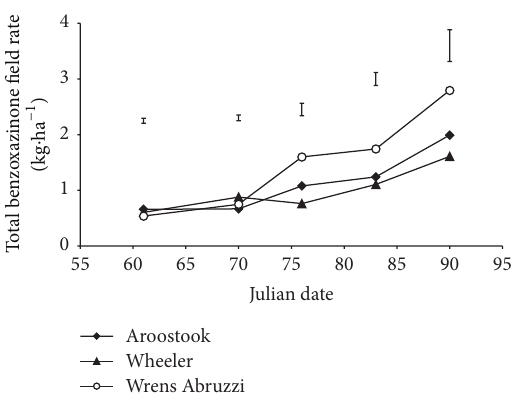
Figure 12: Benzoxazinone field rate (concentration × biomass) at successive dates in rye foliage of four rye varieties during the second year of experiments. Vertical bars represent standard errors at each sampling date.